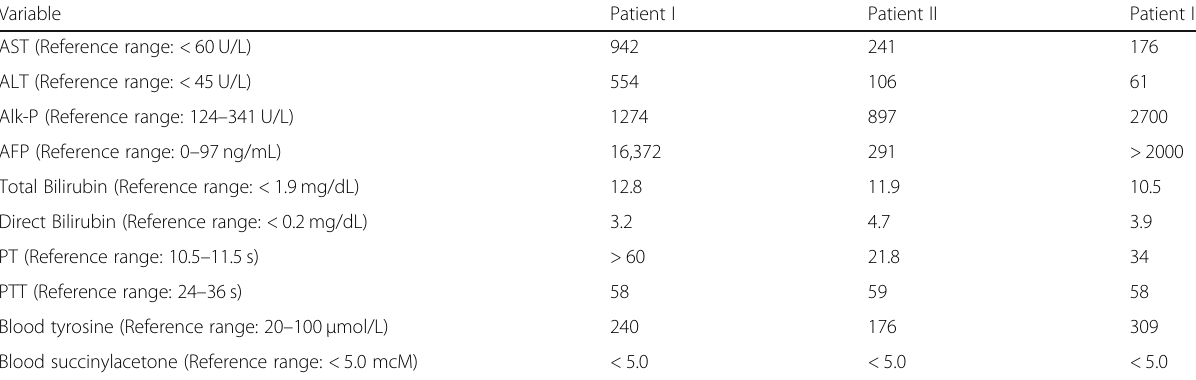
Table 1 Laboratory findings in the patients showing increased Alk-P, AFP, and blood tyrosine levels in all affected individuals